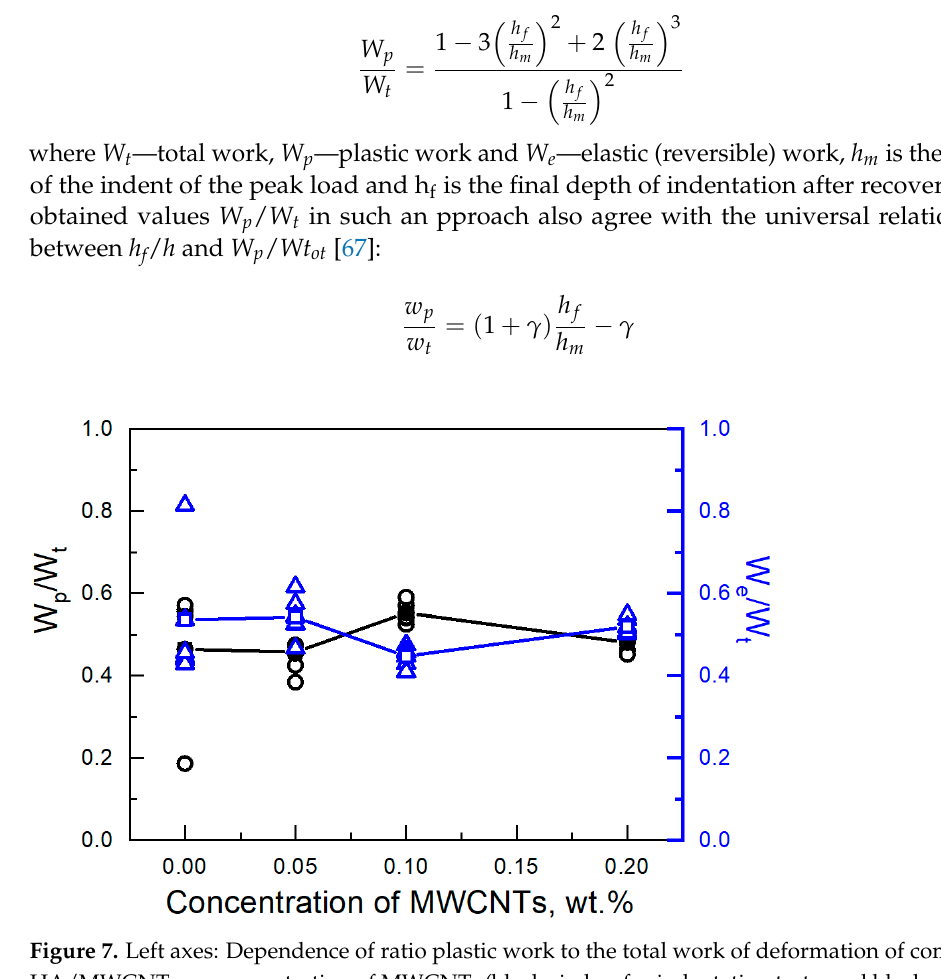
12 of 17 Figure 6. Young’s modulus vs. concentration of MWCNTs. Indentation test (red circles), Average value of the composite HA/MWCNTs (open square). Line shows for the eye the literature values of Young`s modulus for enamel (green line) [61], and Dentin-Enamel Junction (orange line) [64]. The increase in the amount of the MWCNTs additives leads to an increase in the Young’s modulus due to the decrease in the porosity of the HA. On the other side, it was seen in the electron microscope images that the morphology of MWCNTs agglomerates is significantly changed in the ceramics due to partial oxidation of the nanotubes during the sintering [25]. This may lead to a smaller Young’s modulus of the MWCNTs and compo- site ceramics HA-MWCNTs. Thus, the compensation of factors with the opposite effect in the sample leads to a weak change in the Young’s modulus with an increase in the amount of MWCNTs additives. It agrees with the literature data. Both a small increase [36,37] and a decrease [37,38] in the Young’s modulus of the ceramics with the addition of MWCNTs were observed. Fractions of the plastic ( W p / W t ) and elastic ( W e / W t ) work of deformation during in-